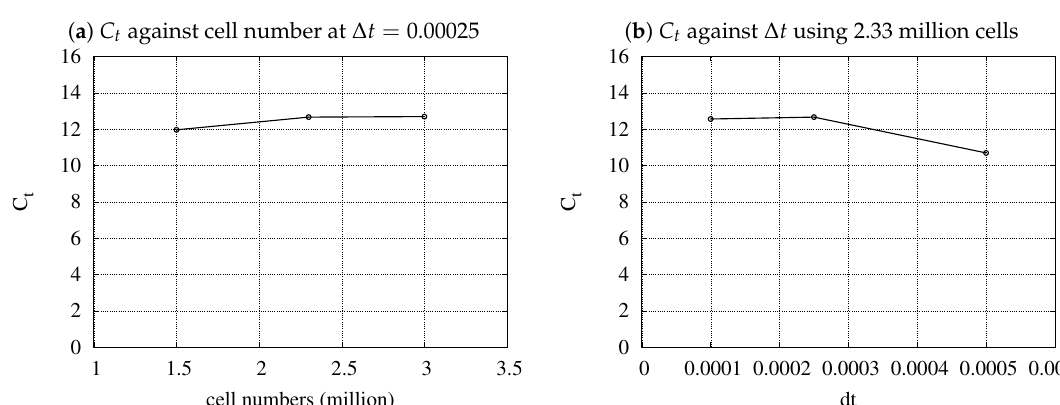
Figure 4. Total resistance ( C t ) computation of model 1 at λ / L = 1.1 for testing grid and time step